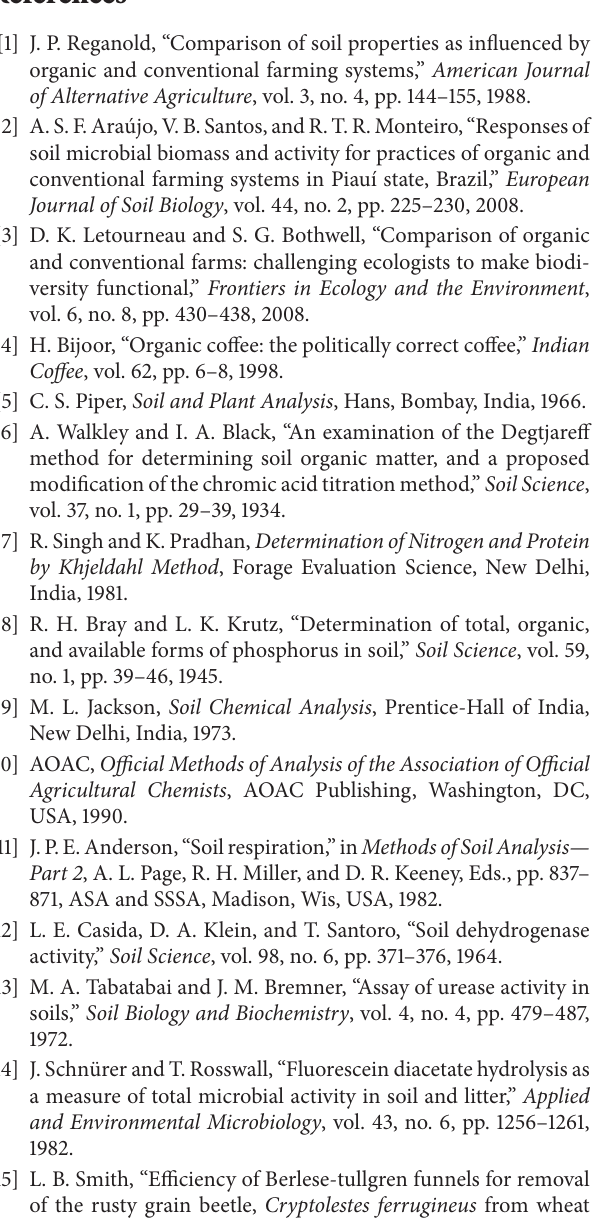
Systems Organic